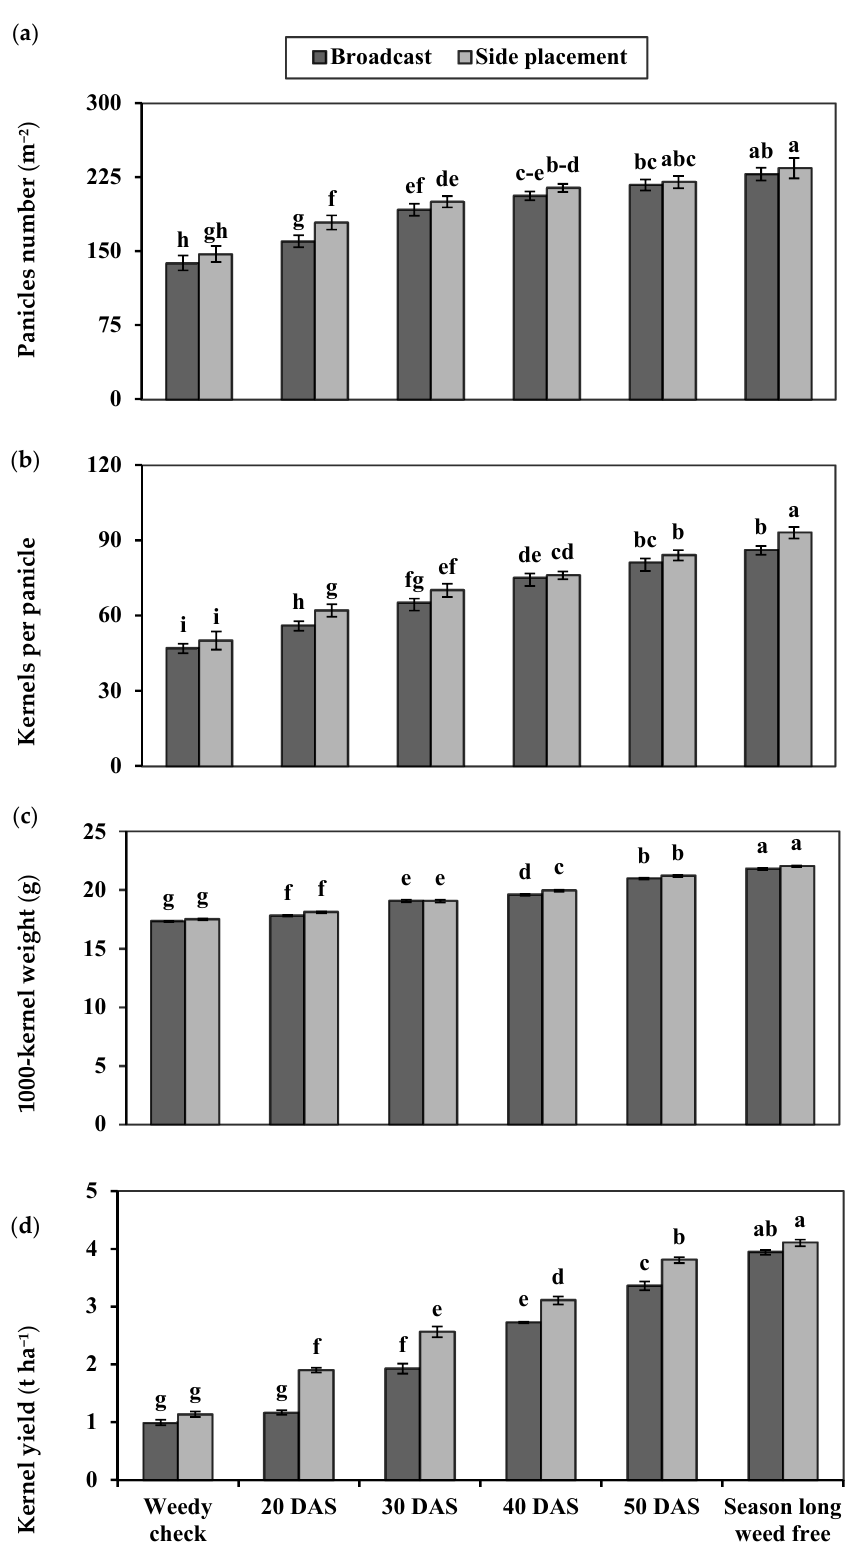
Figure 4. Effects of different weed-free periods on ( a ) number of panicles, ( b ) kernels per panicle, ( c ) 1000 kernels weight and ( d ) kernel yield of direct-seeded rice under different fertilizer application methods. Vertical bars above mean denote the standard error ( ± ) of six replicates and letters depict significane at 5% probability level. Units on x -axis remain same for a, b, c and d figures, (2 years mean